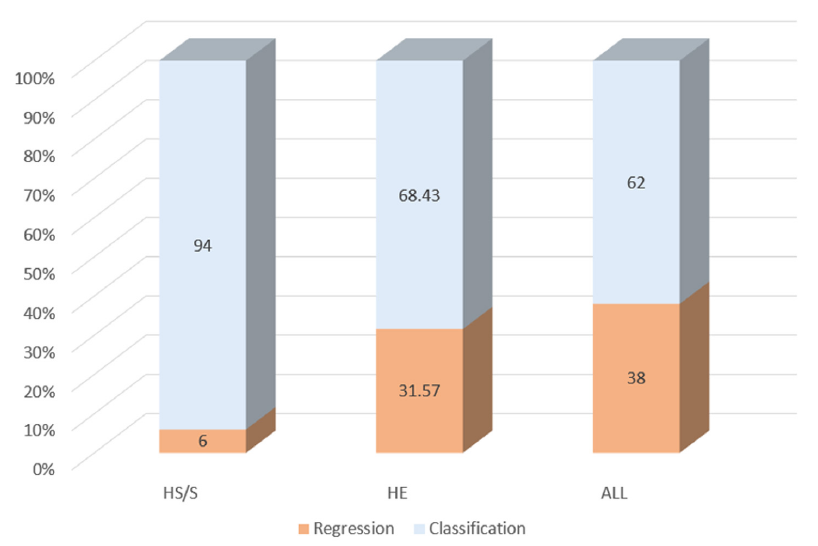
Figure 3. The aims of student performance prediction studies in percentages (regression vs.